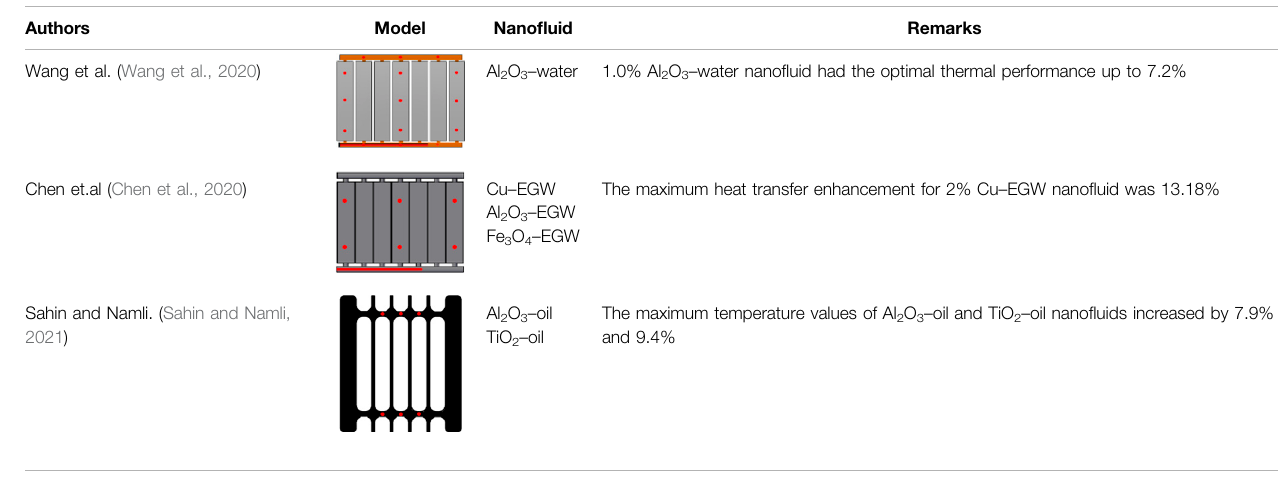
TABLE 6 | Information of nano fl uids in electric heaters.